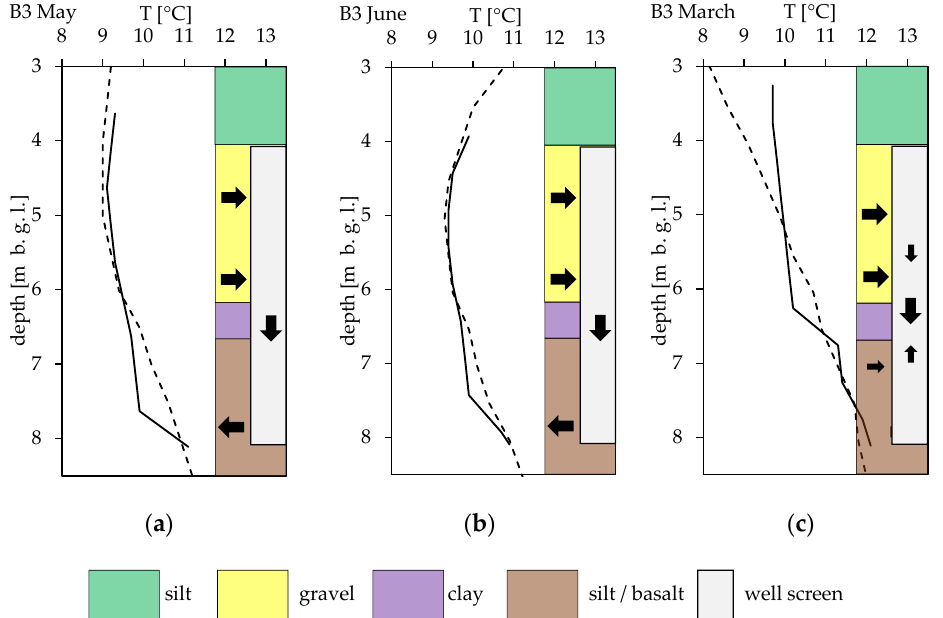
Figure 8. Temperature deviations in MWs due to forced convection. Temperature depth profiles MW (solid line) and surrounding subsurface (TMS, dashed line line) with main soil types and hard rock, flow directions from surrounding bedrock and within MW for selected measuring times based on schematic figures in Berthold and Börner [35]; ( a ) May; ( b ) June and ( c ) March. For ease of representation, interjacent silt layers in the bench gravel were neglected. Moreover, only flow directions caused by forced convection are shown.